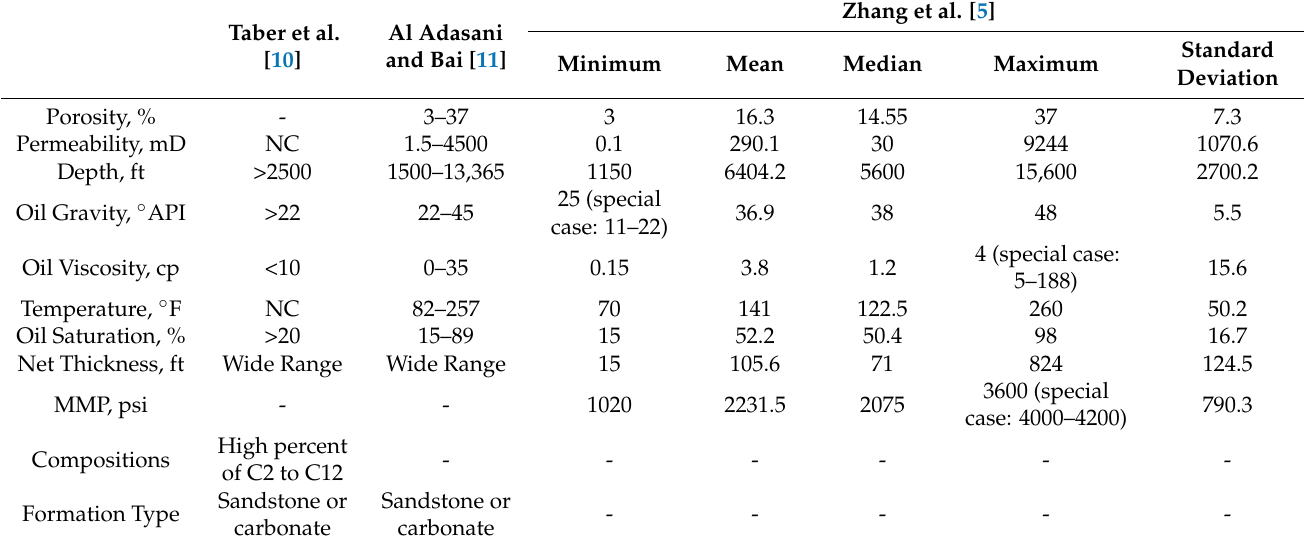
Table 1. Existing screening criteria for miscible CO 2